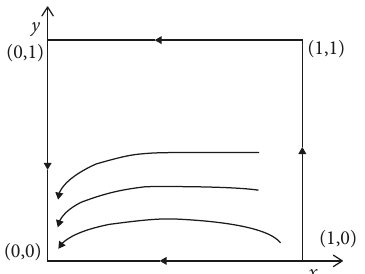
Figure 2: Replicated dynamic phase diagram of system 1 under condition (a).